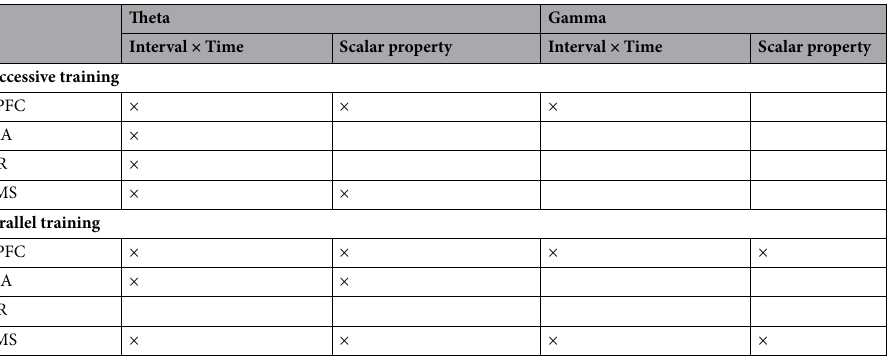
Table 1. Summary of the data obtained for theta and gamma activity power in Good Timers animals in the two experimental paradigms (Successive training and parallel training) and in the four recording sites, for the criteria relevant to interval timing, ie significant Interval × Time interaction and respect of scalar property. mPFC medial prefrontal cortex, BLA basolateral amygdala, PIR olfactory piriform cortex, DMS dorso-medial